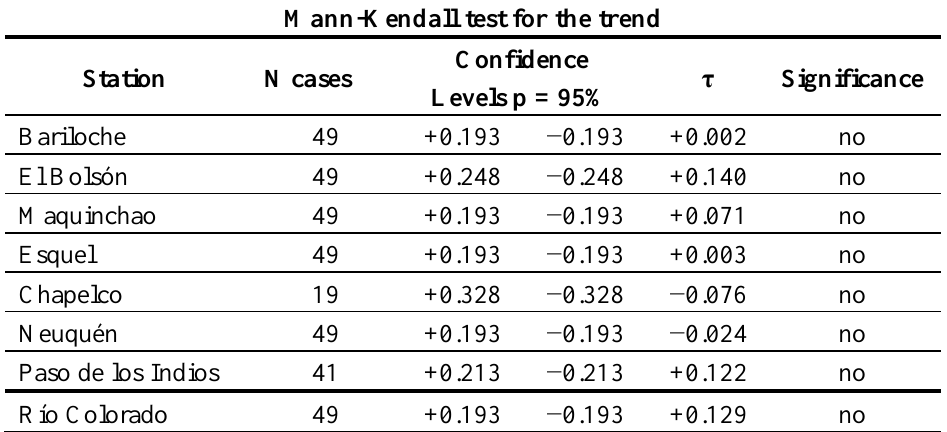
Table 4. Results of Mann-Kendall test assessing a trend in the warm semester